Question: Judging by this figure, is the value going up or going down?
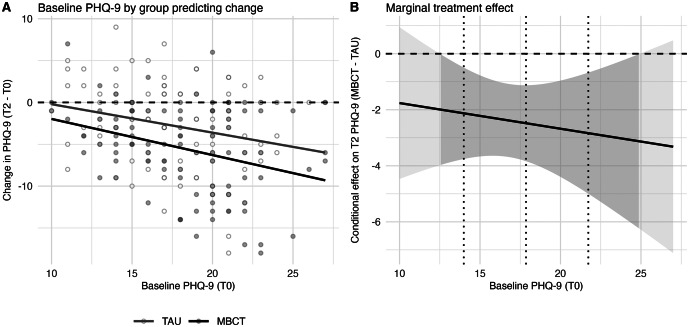
Answer: increasing